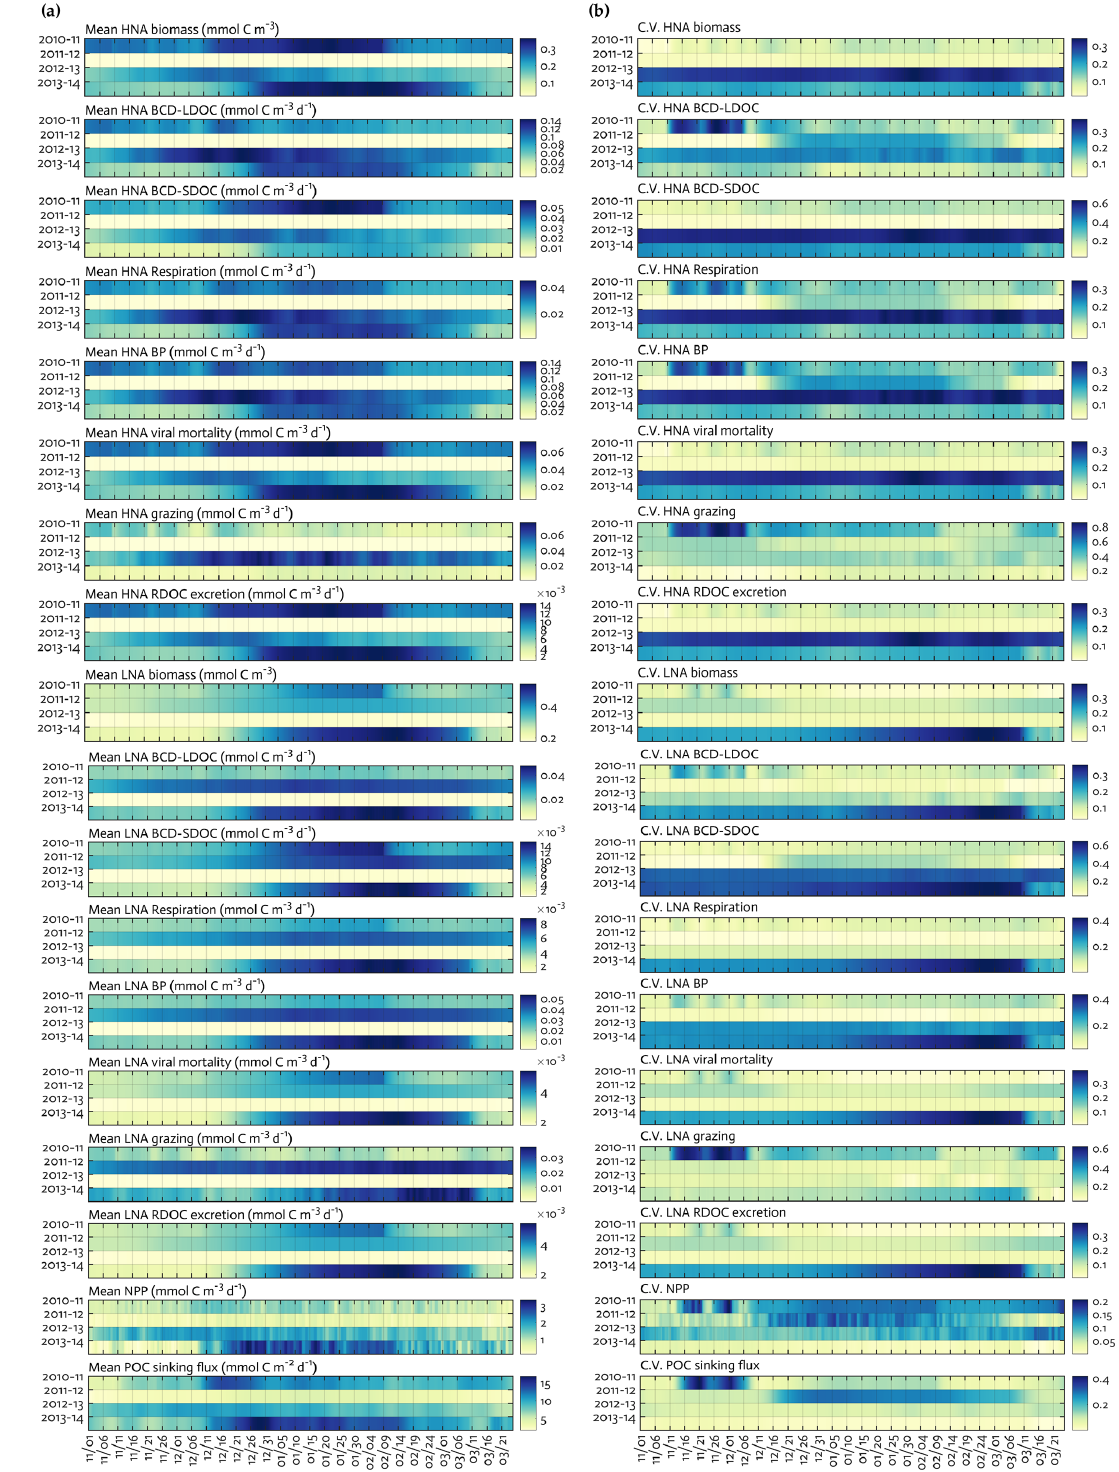
Figure 4. Seasonal progression of modeled HNA and LNA bacterial carbon stocks and rates and key ecosystem functions across years. Seasonal patterns of HNA and LNA bacterial carbon stocks and flows, NPP and POC sinking flux at 10m depth over the growth season (November–March) for each of the 4 simulation years (a) , and coefficient of variation (the Monte-Carlo-derived standard deviation divided by each data point from Fig. 4a) from 1000 Monte Carlo experiments (b)